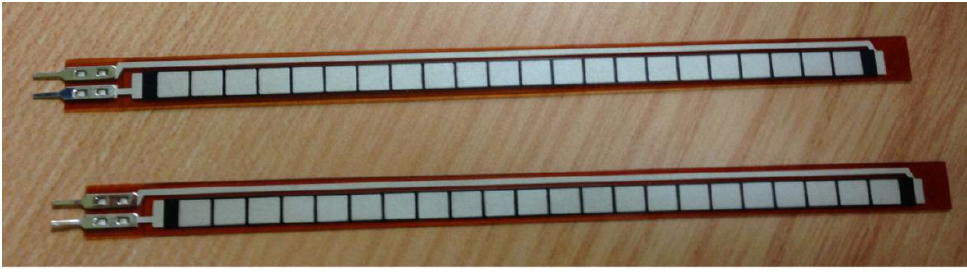
Figure 9. Flexible